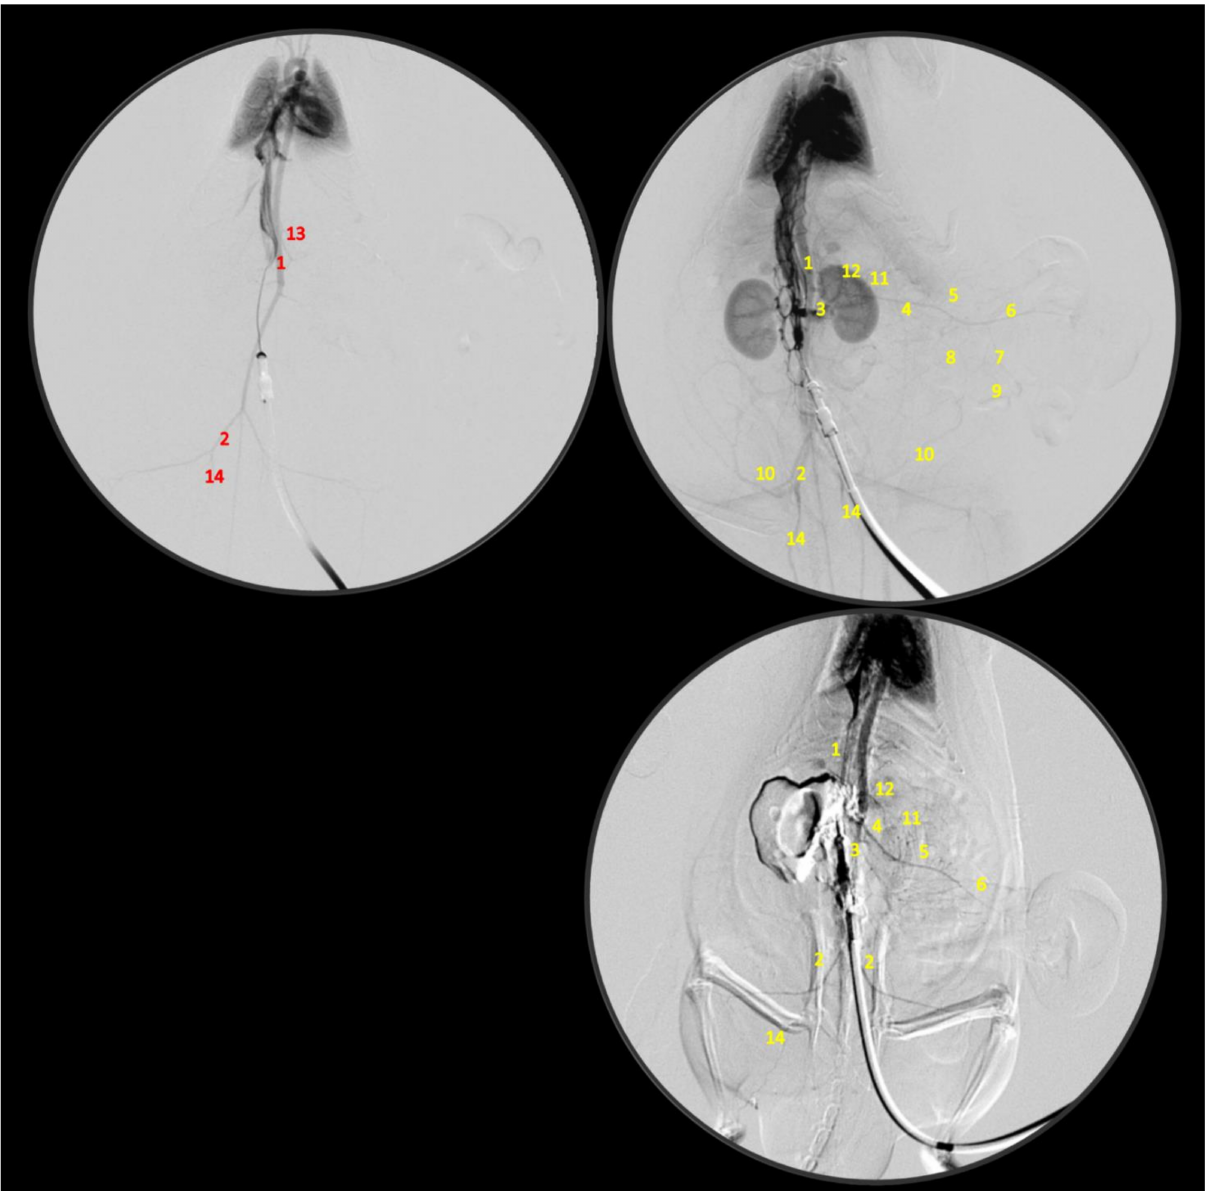
Figure 6. Inferior caval vein venography, and vessels presentation (abdominal aorta (1), common iliac artery (2), renal artery (3), superior mesenteric artery distal to occlusion (4), jejunal branches of superior mesenteric artery (5), ileal branches of superior mesenteric artery (6), ileocolic-right colic truncus (7), middle colic artery (8), ileocolic artery (9), caudal epigastric artery (10), pancreaticoduodenal artery (11), coeliac truncus (12), superior mesenteric artery proximal to occlusion (13), internal iliac artery (14)) in rats with the occlusion of the superior mesenteric vein and artery immediately following medication (BPC 157 10 µ g/kg (upper), or 10 ng/kg (low) (right) or saline 5 mL/kg (left)) given intraperitoneally at 15 min